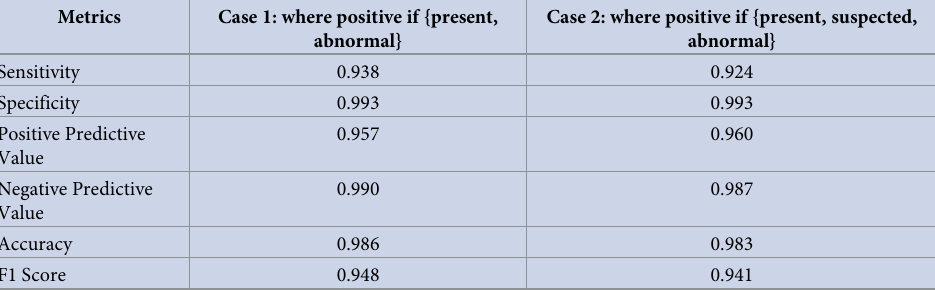
Table 3. tbiExtractor performance